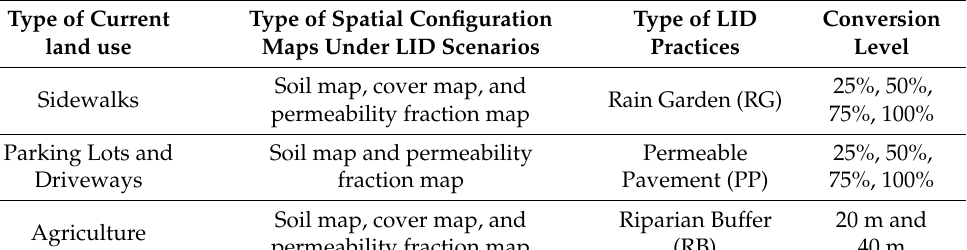
Table 4. LID configurations in the model and conversion levels.